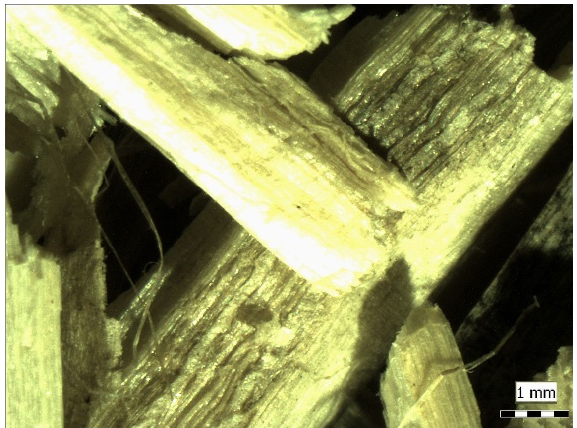
Figure 7. Fiber orientation in hemp shives.